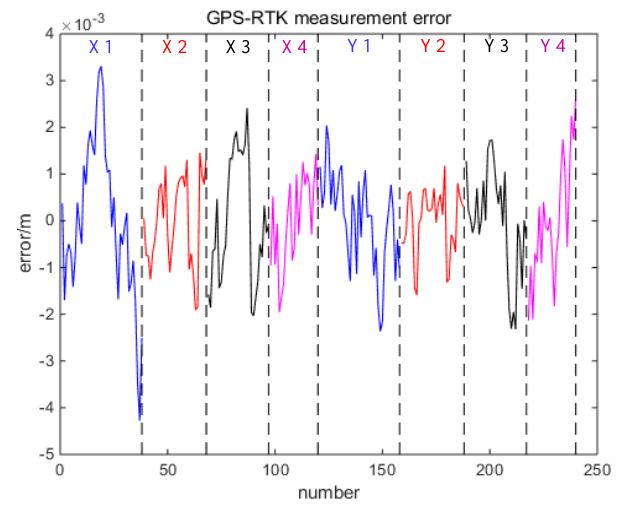
Figure 8. Global Positioning System—Real Time Kinematic (GPS-RTK) measurement error in the Gaussian plane coordinate system.